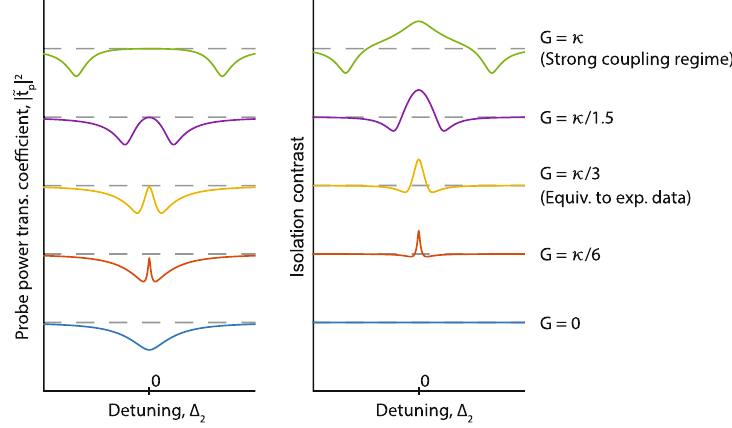
Figure 2. Evolution of the transparency and isolation contrast as a function of pump-enhanced Brillouin coupling G . In the weak coupling regime ( κ  G ), the transparency linewidth and contrast bandwidth are defined by the acoustic linewidth Γ B 26 . As coupling G increases, the isolation contrast improves, bandwidth is expanded and the optical mode with transparency appears as a splitted mode. In the strong coupling regime, the isolation bandwidth is independent of the acoustic mode and is instead defined by optical mode linewidth κ only. The dashed lines indicate the perfect transmission baseline (left) and zero isolation contrast (right)